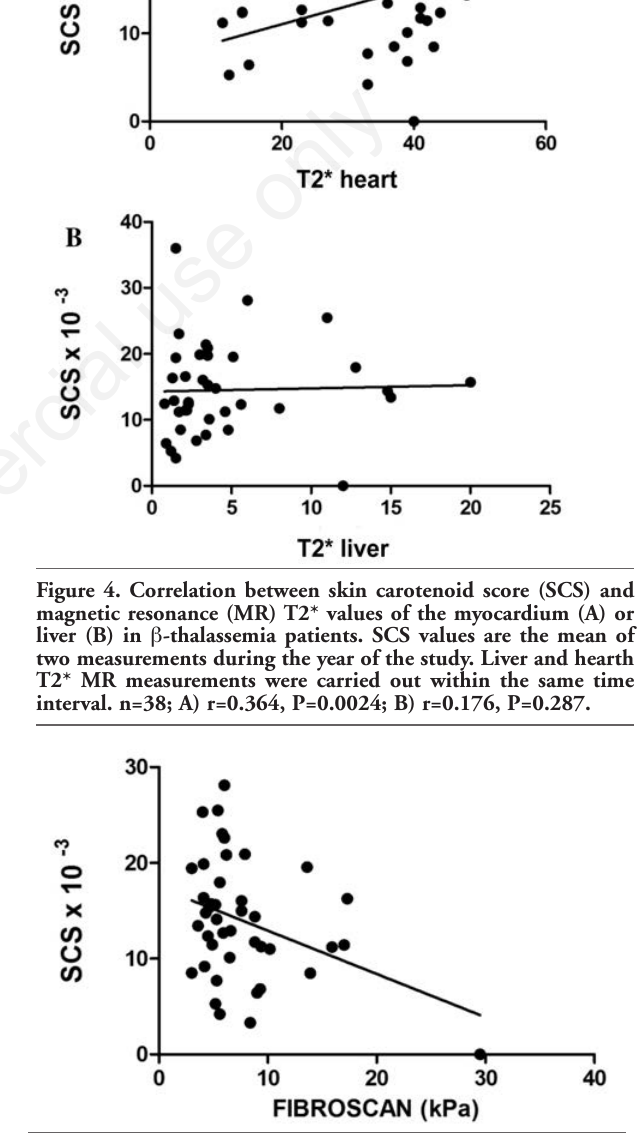
Figure 5. Correlation between skin carotenoid score (SCS) and liver stiffness in b -thalassemia patients. Liver stiffness was meas- ured by transient elastography (FibroScan®). SCS values are the mean of two measurements during the year of the study. FibroScan® examination was carried out within the same time interval (n=42; r=−0.3599,